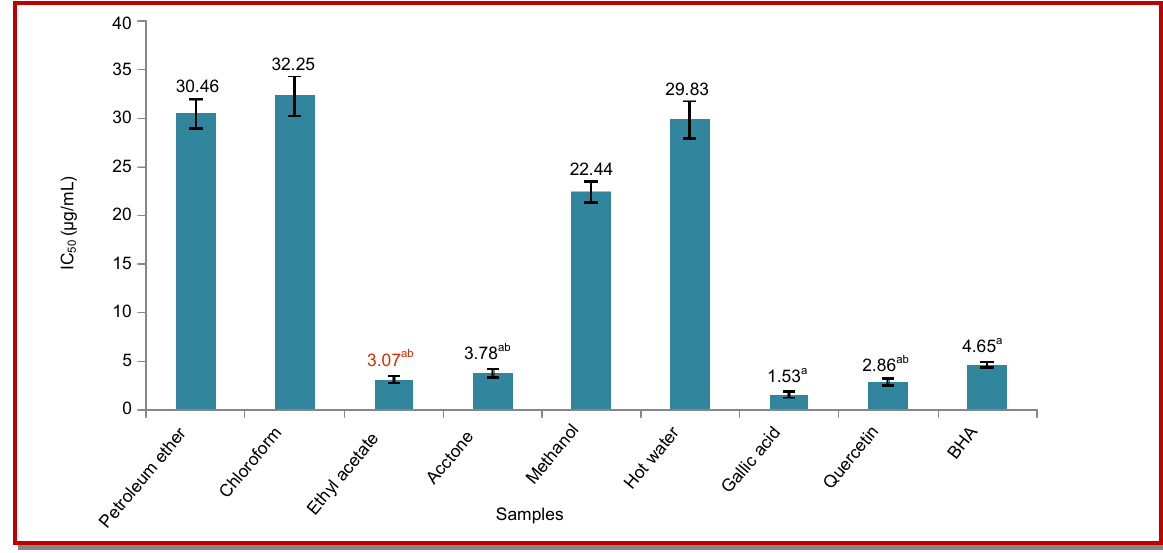
Figure 1: DPPH radical scavenging activity Values are mean of triplicate determination (n=3) ± standard deviation; Statistically significant at p<0.05 where a >